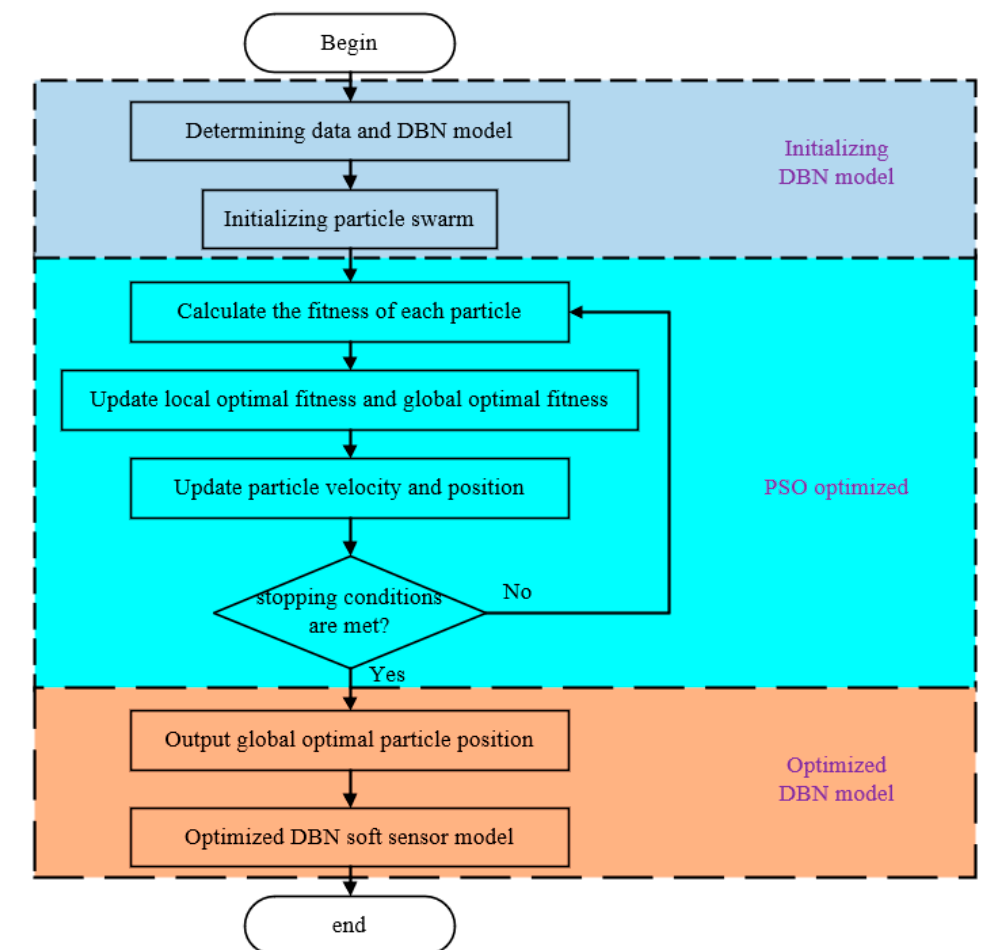
Figure 5. Flow chart of DBN soft-sensing model optimized by PSO.